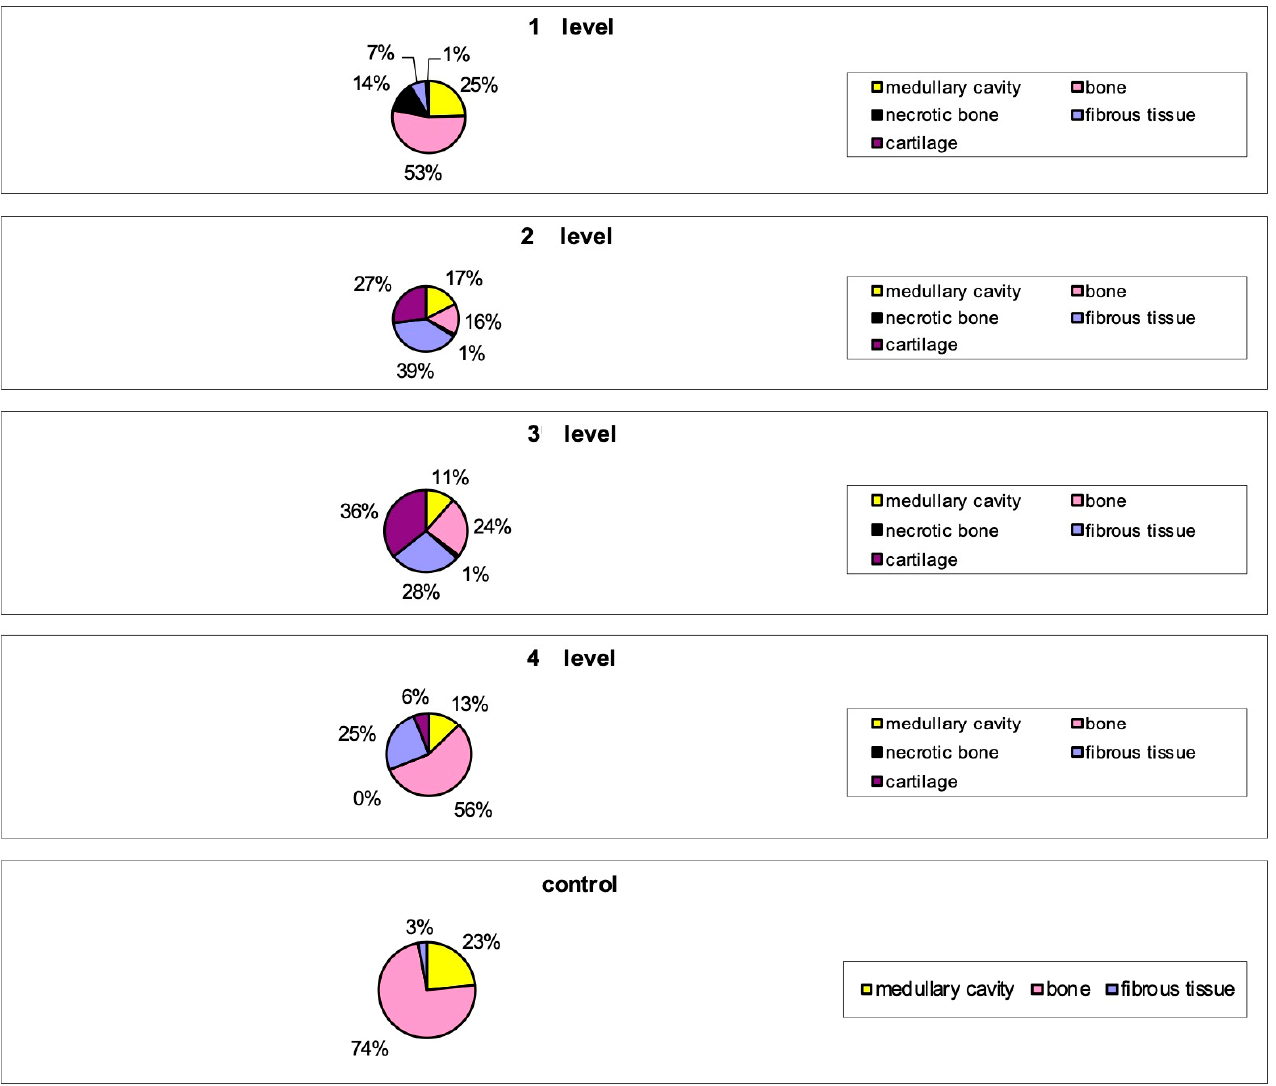
Scheme 1. Percentage areas occupied by different tissues in the fractured diaphyseal levels and contralateral healthy